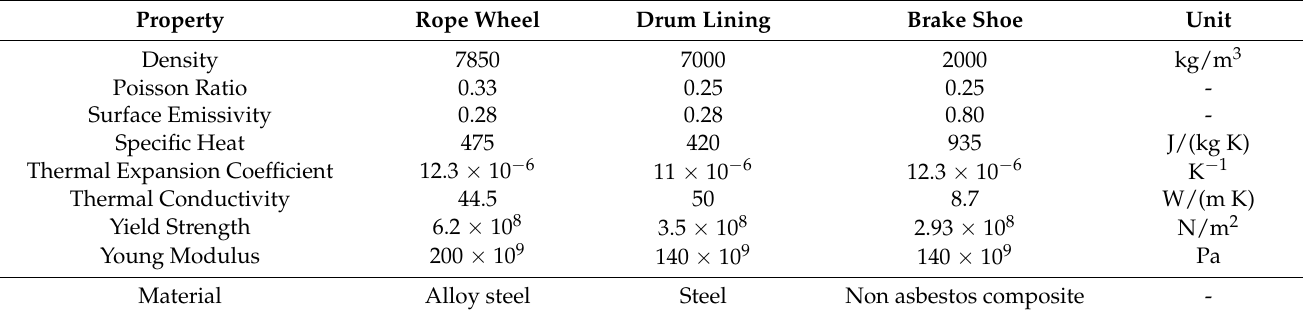
Table 3. Materials and properties for the studied mine hoist brake system components.